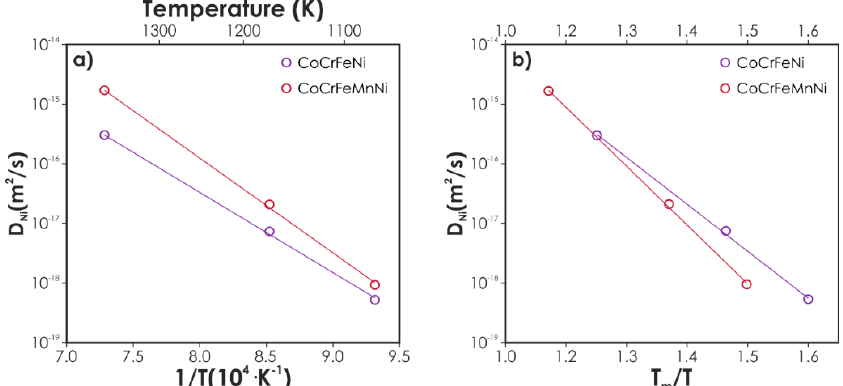
Figure 4. Arrhenius plots for Ni di ff usion in CoCrFeNi and CoCrFeMnNi alloys plotted using: ( a ) inverse absolute temperature, ( b ) inverse normalized temperature (after [31]). Reprinted from Journal of Alloys and Compounds 688 (2016), Ni tracer di ff usion in CoCrFeNi and CoCrFeMnNi high entropy alloys, 994–1001, Copyright 2016, with permission from Elsevier.